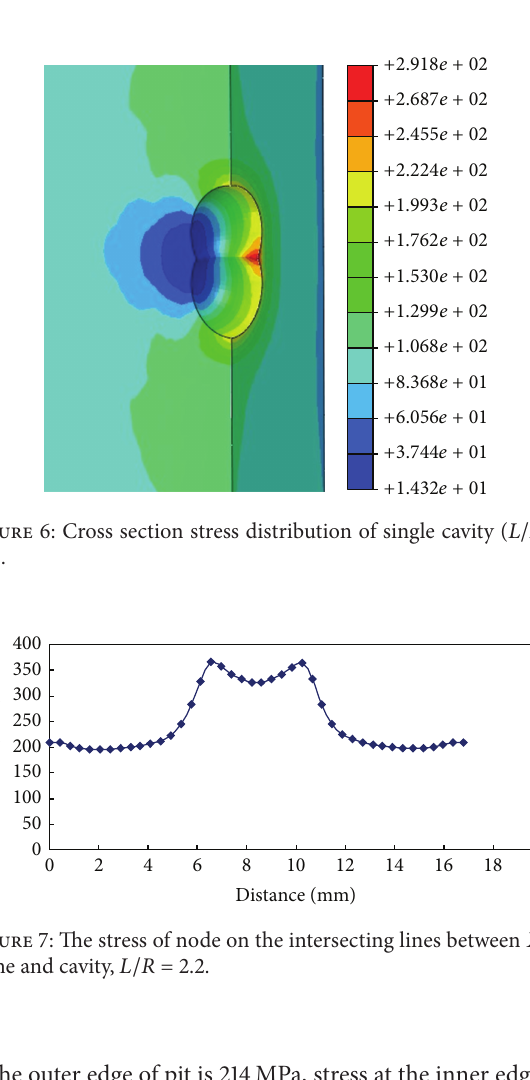
Figure 4: Finite element models of two spherical pits in casing internal surface.